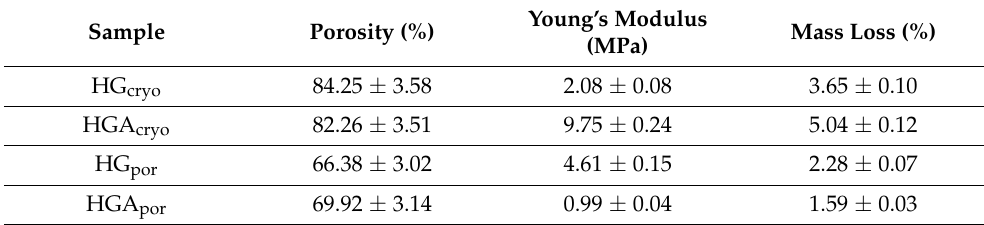
Table 2. Values of porosity, Young’s modulus, and percentage of degradation for hydrogel scaffolds.